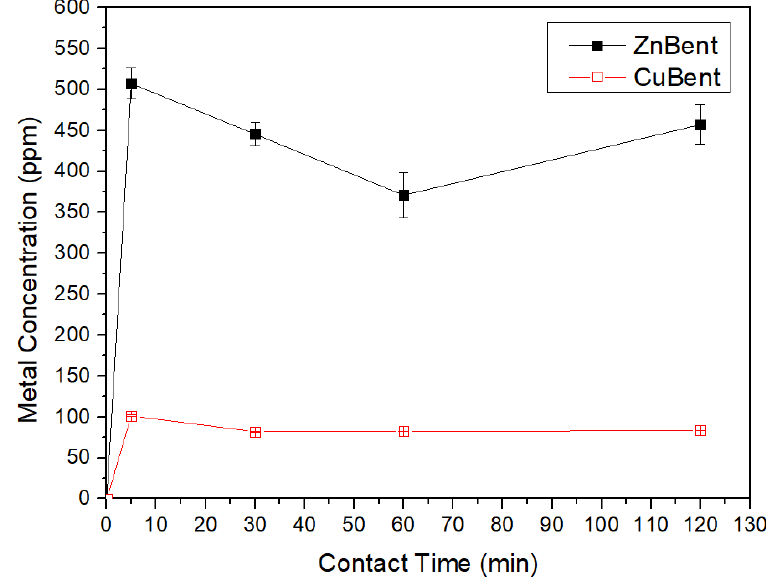
Figure 4. Concentrations of Ζn and Cu in PBS in relation to contact time.